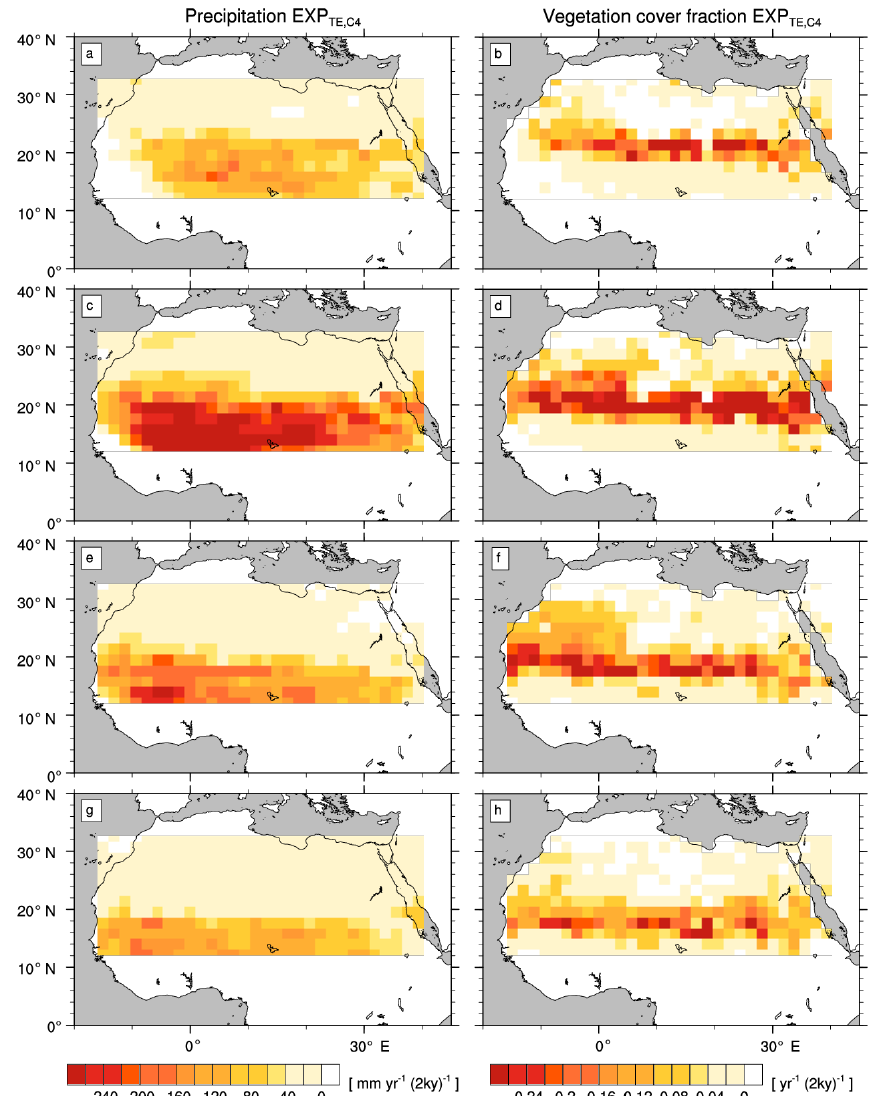
Figure A2. Transition rates from the green Sahara to the desert state for precipitation P (left column) and vegetation cover fraction veg max (right column) of a simulation with C 4 grass and tropical evergreen tree (EXP TE , C